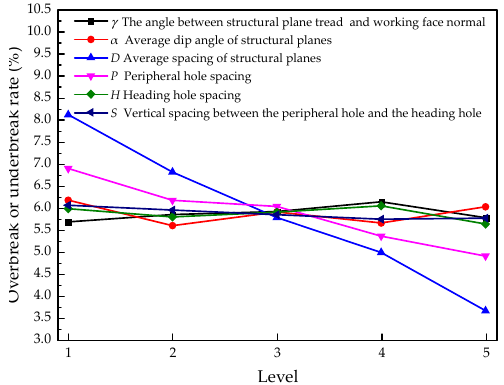
Figure 13. Overbreak or underbreak rate of smooth blasting under different levels of each factor in the layered structure rock mass. the layered structure rock